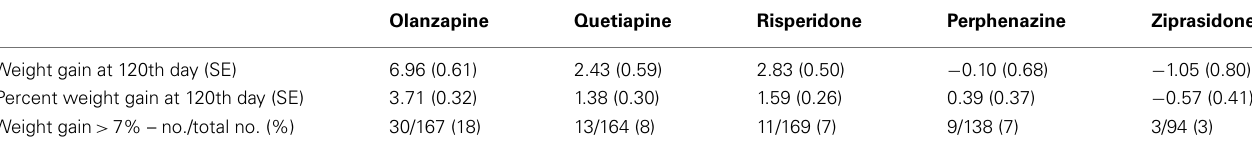
Table 4A |Weight measures without adjusting for covariates (Model 2: weight gain was estimated separately for each treatment).